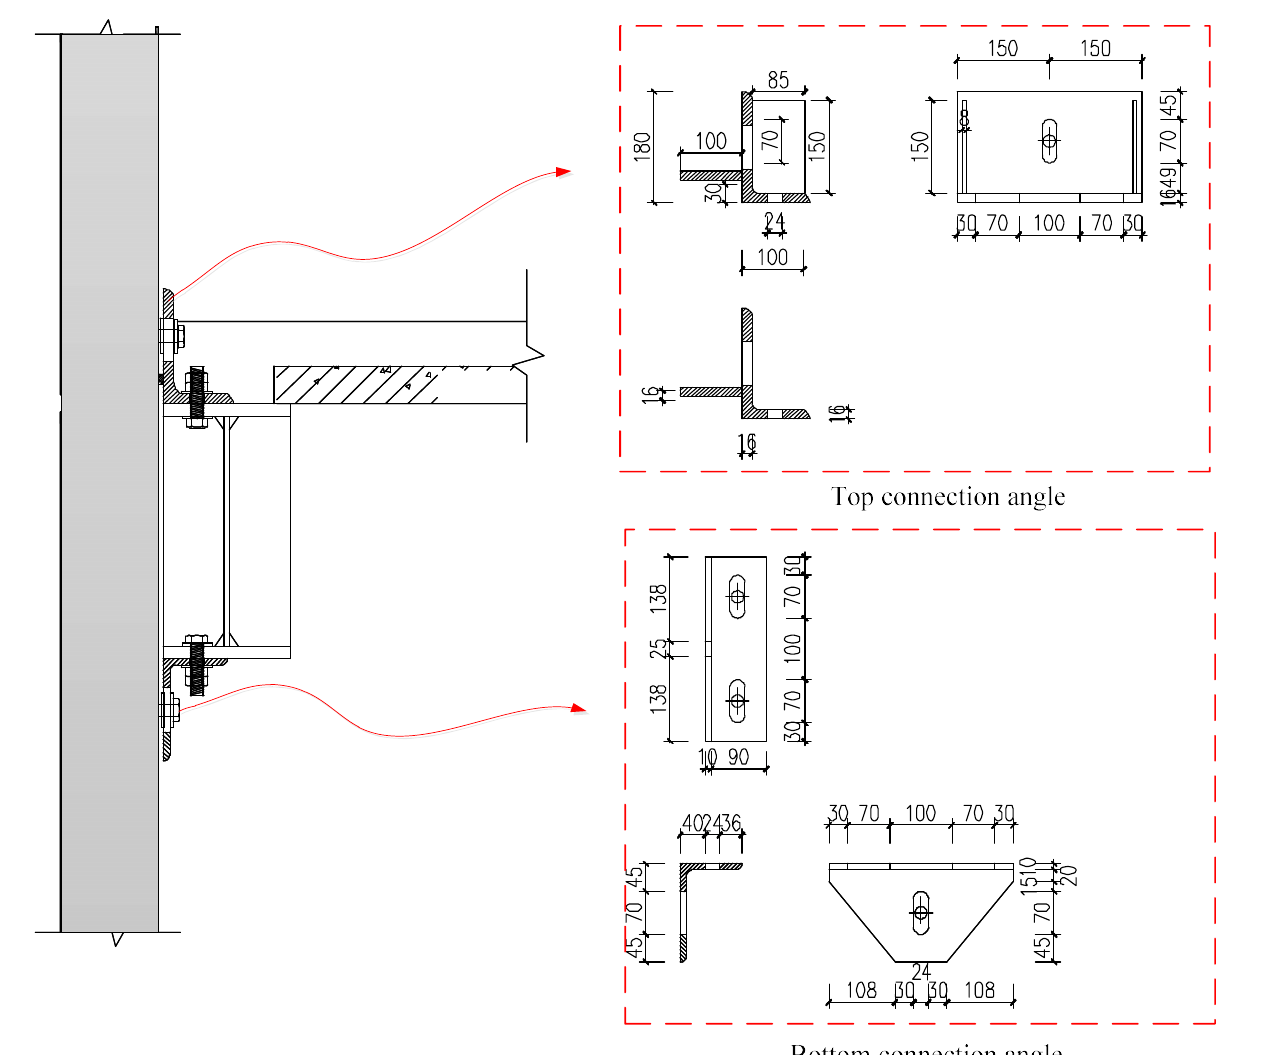
Figure 2. Connection details (Unit: mm).